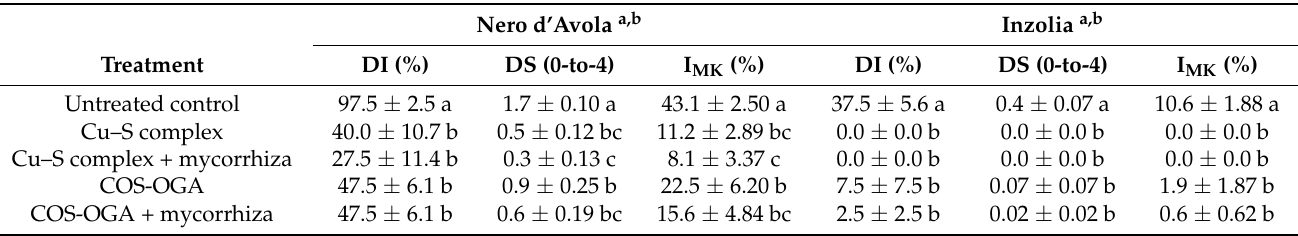
Table 6. Post-hoc analyses of treatment effects on disease incidence (DI), severity (DS) and McKinney’s index (I MK ) of sour rot caused by phytopathogenic bacteria and yeasts on Nero d’Avola and Inzolia wine grapes.